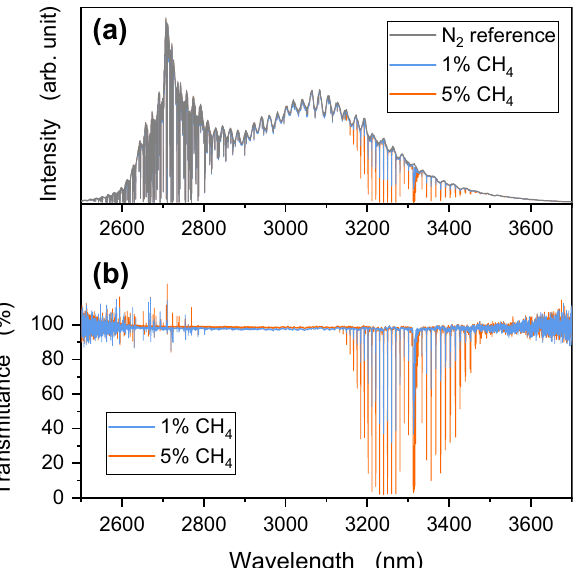
Figure 9. ( a ) Normalized intensity as a function of wavelength. ( b ) Transmission spectrum at each